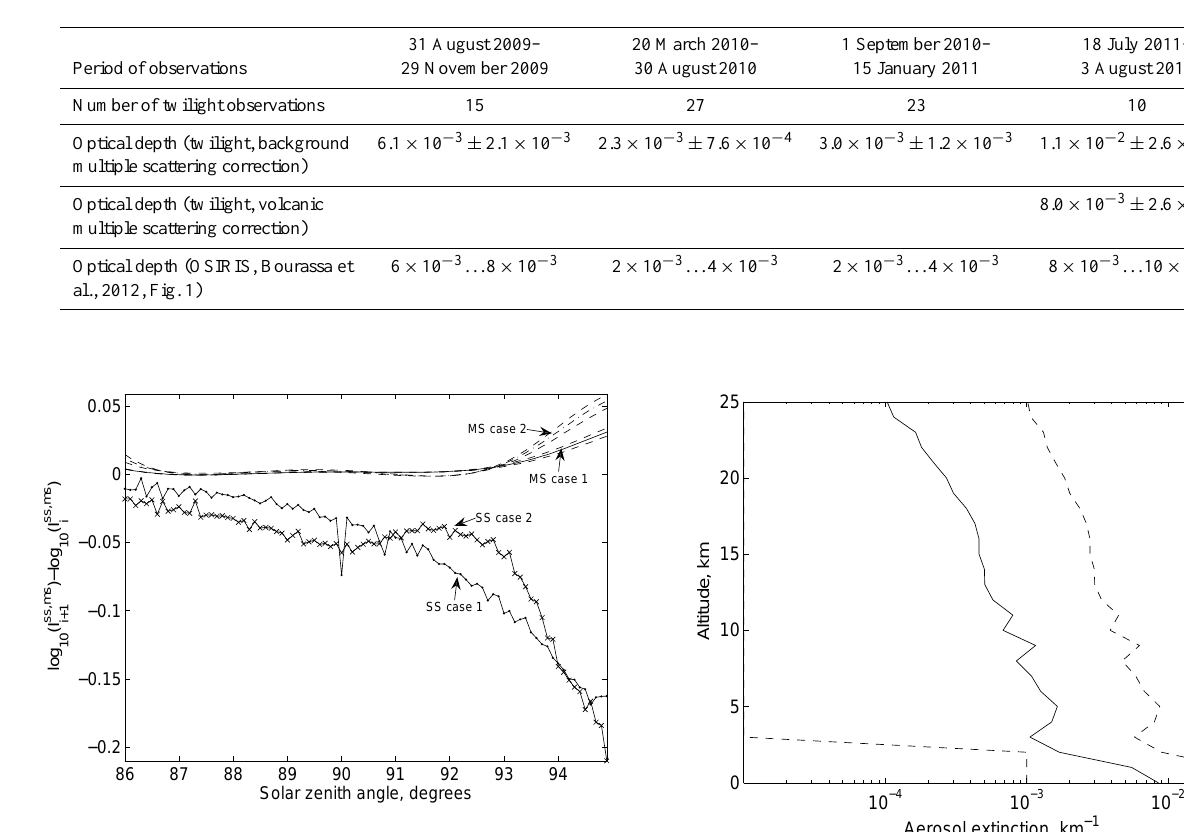
Fig. 6. First differences of logarithms of the single scattering (SS) intensities and multiple scattering (MS) correction factors (solid and dash-dotted line) modelled by the Monte Carlo code for the two aerosol extinction profiles presented in Fig. 5b. VZA = 45 ◦ . The multiple scattering correction factor curves are averaged over 10 Monte Carlo simulations and smoothed. The uncertainties of the multiple scattering contributions are shown by dashed lines.